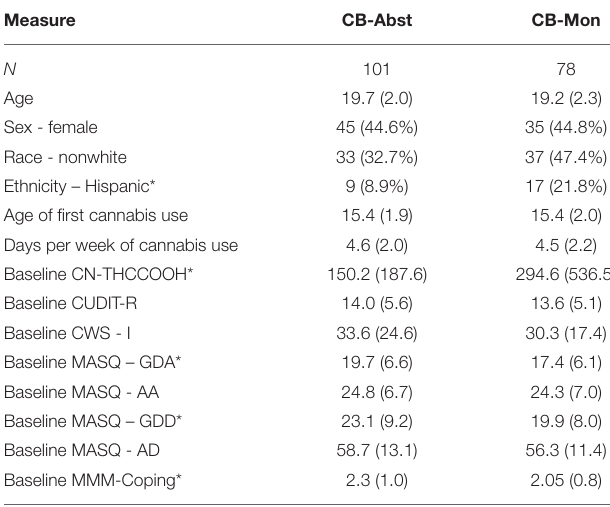
TABLE 1 | Participant characteristics by CB-Abst and CB-Mon